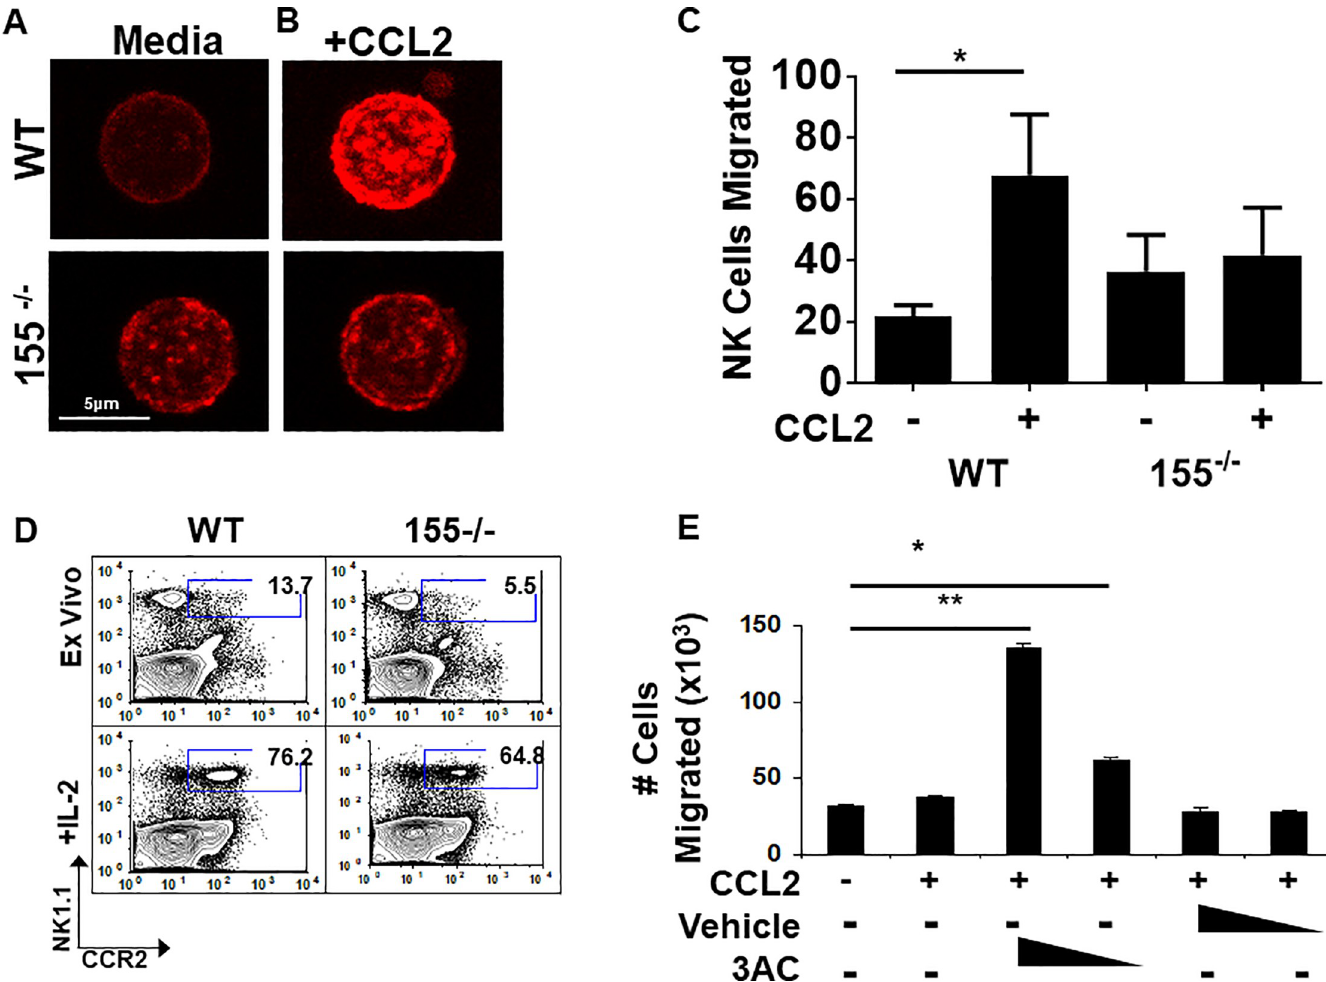
Fig 2. miR-155 -/- NK cells exhibit an altered response to CCL2. IL-2 activated NK cells were generated from WT or miR-155 -/- purified splenic NK cells. Data shown is a representative of three experiments unless otherwise stated. A) Representative images of untreated or B) CCL-2-treated IL-2 activated cells stained with rhodamine- conjugated Phalloidin to detect F-actin. Magnification = 1833.3x; Scale bar = 2 um. C) A Boyden chamber assay was utilized to detect IL-2 activated cell migration towards a CCL2 stimulus. Data shown is the absolute number of NK cells migrated toward the stimulus as determined by flow cytometry using CountBrite beads. D) Na ï ve or 24-hour IL-2 activated splenocytes were analyzed by flow cytometry for co-expression of NK1.1 and CCR2. E) Splenocytes were activated with IL-2 for 24h, followed by treatment with the SHIP-1 inhibitor, 3AC. A Boyden chamber assay was then utilized to detect cell migration towards a CCL2 stimulus. Data shown is the absolute number of NK cells migrated toward the stimulus as determined by flow cytometry using CountBrite beads. � P < 0.05, �� P < 0.01, ��� P < 0.005.